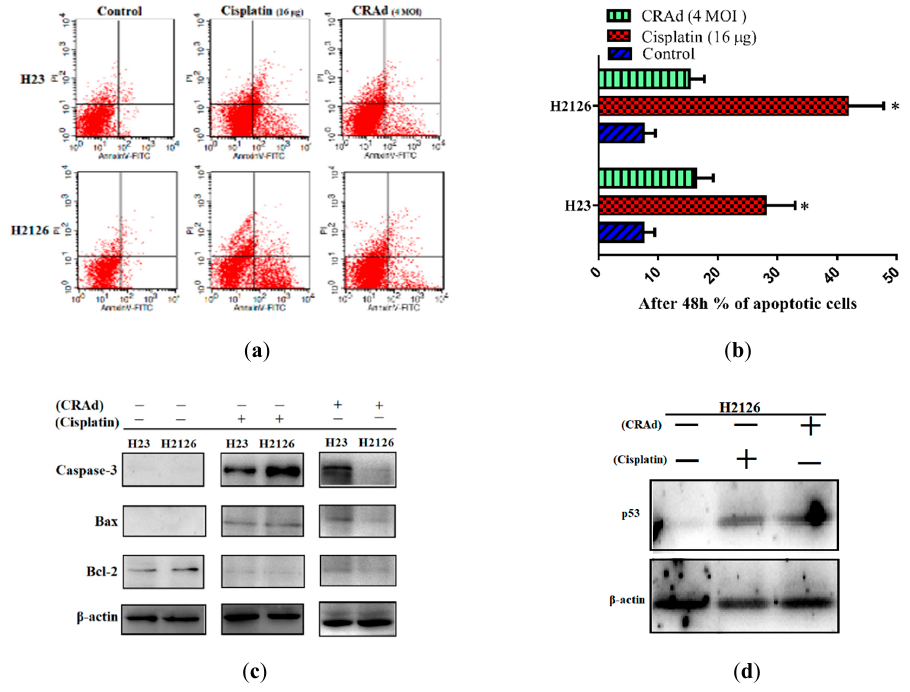
Figure 6. Effects of monotherapies of cisplatin and CRAd on apoptosis in lung adenocarcinoma cells. ( a , b ) Flow cytometry was performed to evaluate the impact of treatments on apoptosis. Results showed that both cisplatin and CRAd increases apoptosis in H23 and H2126 lung cancer cells as compared to DMSO treated controls. One out of three of the experiments with the same results is shown (* p < 0.01). ( c ) Western blots showed that the protein levels of bax and caspase-3 are increased while that of bcl-2 (anti-apoptotic protein) is reduced. It suggests that both treatments activate mitochondria/caspase apoptotic mechanism. ( d ) Similarly, p53 expression was also observed to be increased in H2126 lung cancer cells in both treatments